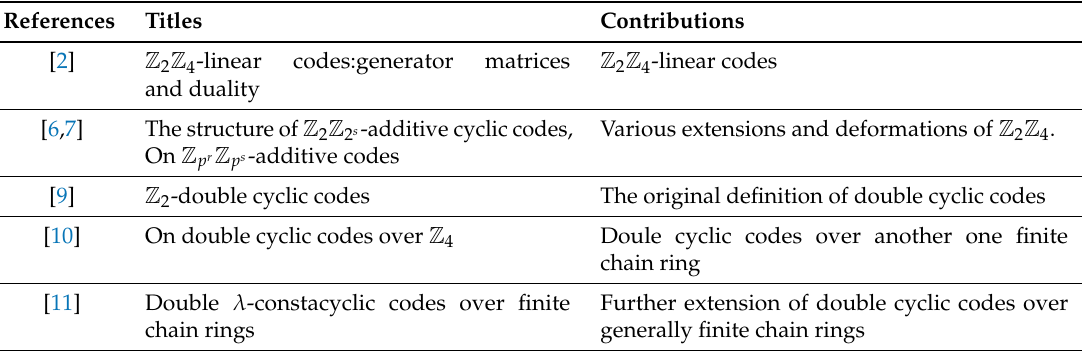
Table 1. The table of authors’ contributions to the history of double cyclic